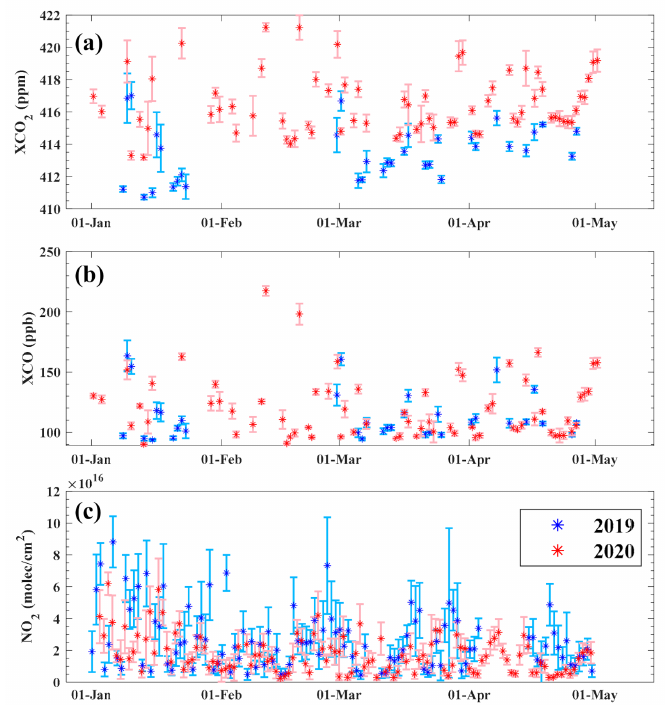
Figure 3. Time series of XCO 2 ( a ), XCO ( b ), and NO 2 ( c ) columns from January to April 2019 (blue) and 2020 (red). The asterisk present the daily mean of XCO 2 , XCO, and NO 2 columns and error bars show the standard